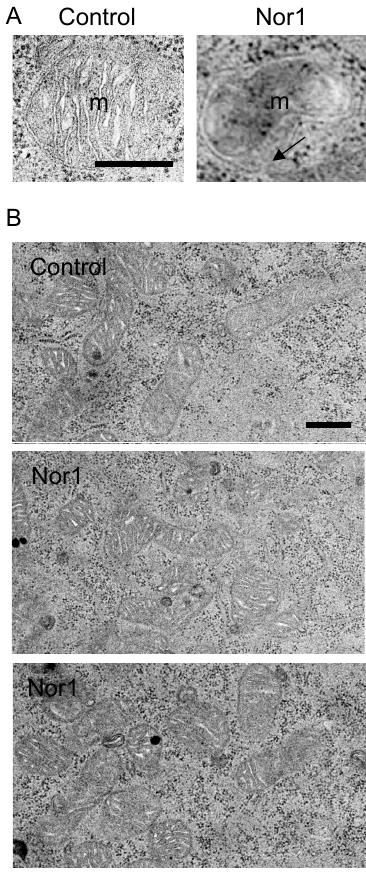
Figure 3. Representative TEM images of mitochondria from INS832/13 cells transfected with Nor1 versus control. ( A ) Nor1 transfected cells displayed occasional hernia and breaks in the outer mitochondrial membrane (indicated by the arrow). m, mitochondria. ( B ) Representative lower magnification images of control and Nor1-overexpressing cells. Scale bars = 500 nm.